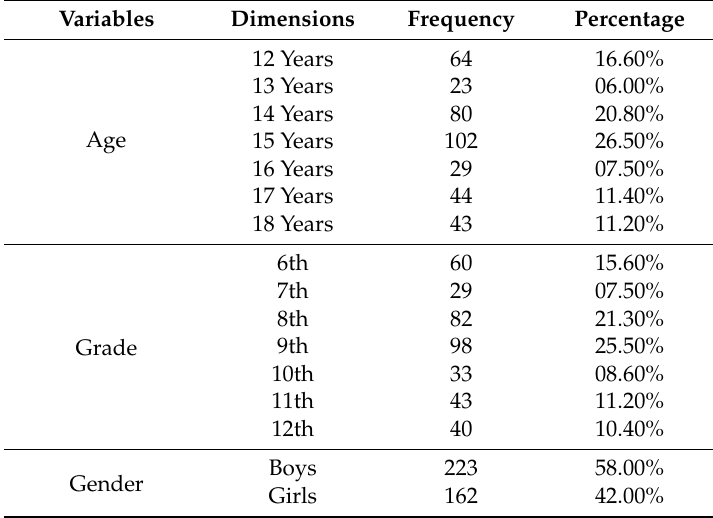
Table 1. Demographic